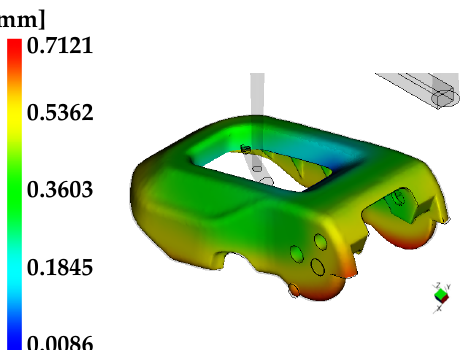
Figure 15. Deflection for the open lever with 0.5% shrinkage-rate constant applied. Table 24. Results of measurement 1, 2, 3 for the open lever applied 0.5% shrinkage-rate constant. Description